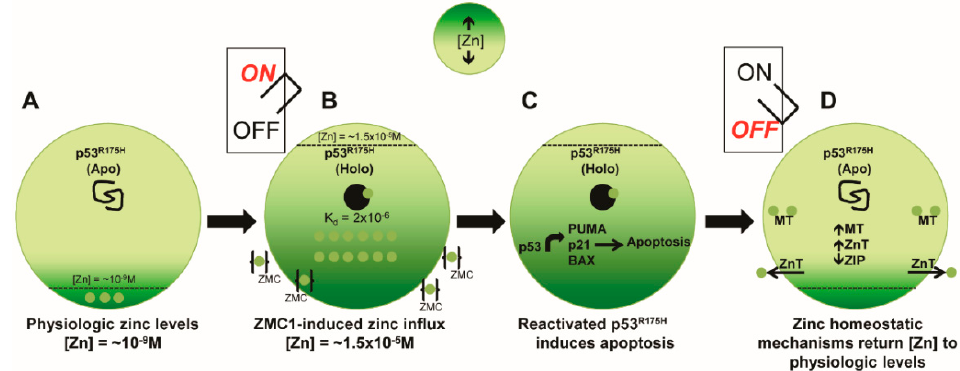
Figure 2. The ZMC Switch mechanism. ( A ) At physiologic zinc levels (10 − 9 M), p53 R175H is in its Apo (zinc free) state because the mutation weakens its binding at the native ligation site (p53 R175H Zn K d2 × 10 − 6 ). This causes the protein to misfold and lose its wild-type transcriptional function. ( B ) Upon treatment with a ZMC, intracellular zinc levels increase approximately 1000 fold (1.5 × 10 − 5 M), and this allows zinc to bind in the p53 R175H native ligation site and the protein adopts a wild-type conformation (on switch). ( C ) Once the protein undergoes a wild-type conformation change, the p53 R175H exhibits wild-type transcriptional activity and an apoptotic mechanism is induced. ( D ) Within hours the cell responds to this zinc surge by activating zinc homeostatic mechanisms (increasing expression of metallothioneins, zinc exporters, decreasing the expression of zinc importers) that function to lower cellular zinc levels to physiologic range. Zinc is no longer at a sufficient concentration to remain bound in the p53R175H and the protein returns to its Apo state (off switch).